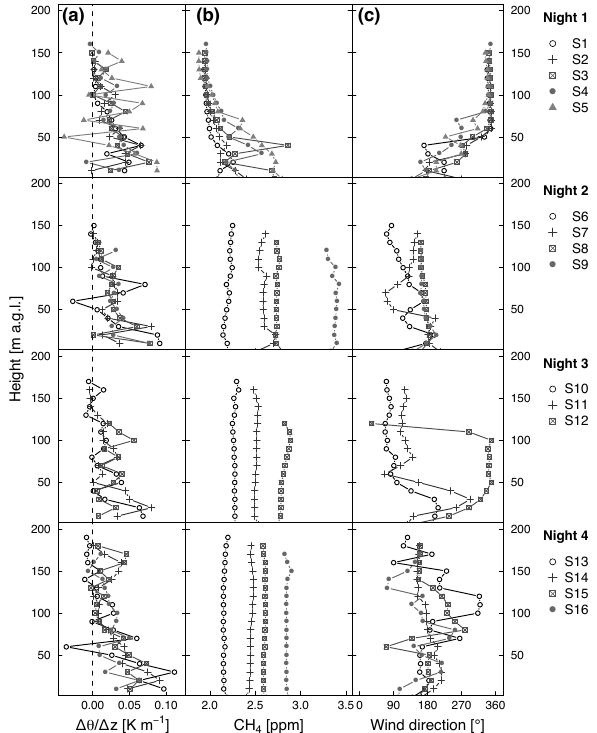
Figure 3. Vertical profiles of (a) potential temperature gradients, (b) CH 4 concentrations, and (c) wind directions of the individual balloon soundings. The dashed vertical lines indicate neutral strat- ification in (a) and lower and upper wind direction limits used for the NBL budget flux calculation in (c)